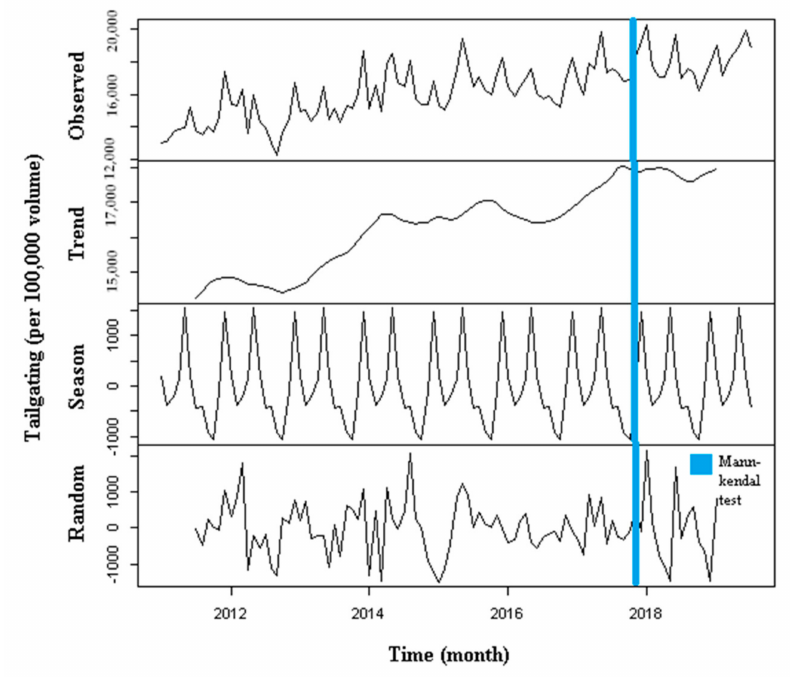
Figure 5. Decomposing the additive time series on a monthly basis for tailgating per 100,000 vehicles in Iran, with blue vertical lines showing the points analyzed with a Mann-Kendall Test, from March 2011 to October